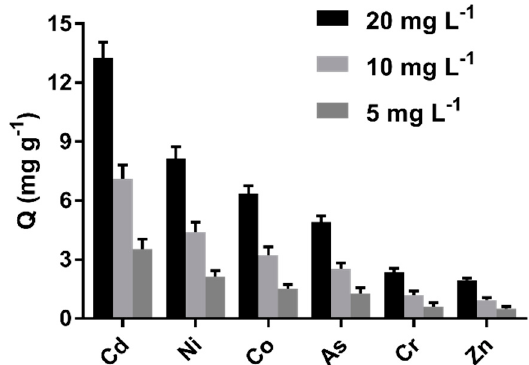
Figure 8. Adsorption selectivity of cystamine-modified biochars (C 0.75 ) toward different heavy metal ions.